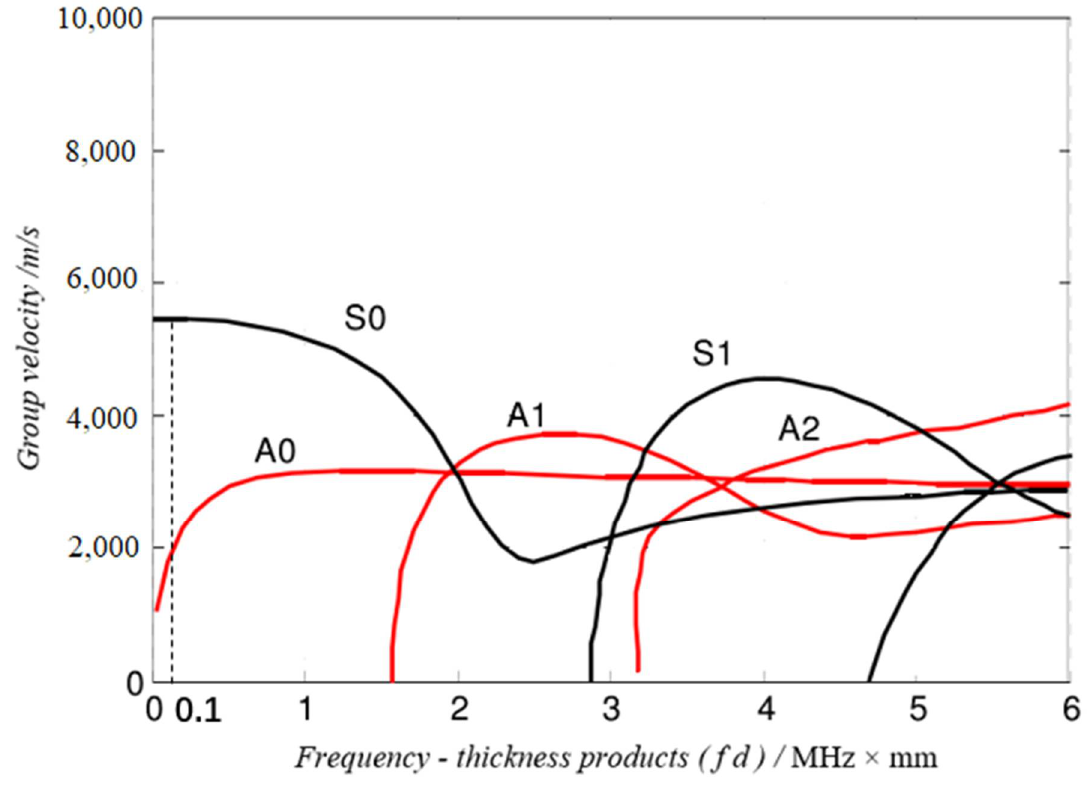
Figure 1. Dispersion curve of Lamb wave propagating in an aluminum alloy